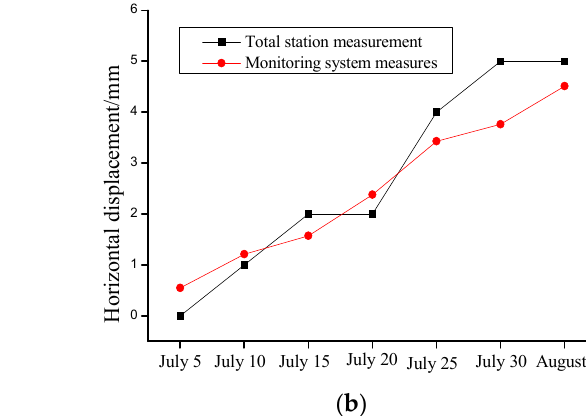
Figure 12. Time history curve comparison. ( a ) Time history curve of No. 1 measuring point, ( b ) Time history curve of No. 2 measuring point.